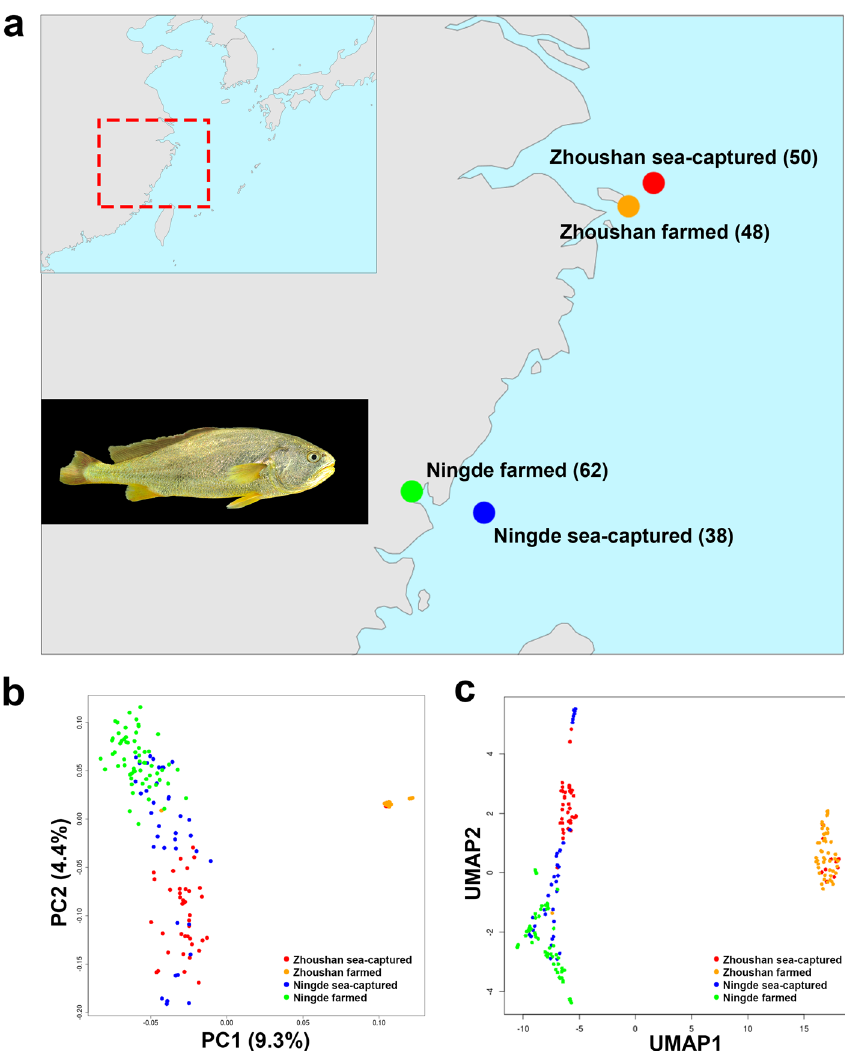
Figure 1. Population structure and relationship of large yellow croaker. ( a ) Geographic map indicating the sample origins of the large yellow croaker in this study. The gross appearance of a large yellow croaker individual is shown in the picture. The sampling area is highlighted by the red broken line. The dots of different color stand for different population. The number of individuals is given in parentheses after the population name. The geographical maps were generated by using R packages of maps v3.3.0 (https:// cran.r- proje ct. org/ web/ packa ges/ maps) and mapdata v2.3.0 (https:// cran.r- proje ct. org/ web/ packa ges/ mapda ta). ( b ) PCA plot (PC1 and PC2) showing the genetic structure of the 198 large yellow croaker individuals. The degrees of explained variance is given in parentheses. Colors reflect the geographic regions in ( a ). ( c ) UMAP of the 198 large yellow croaker individuals. Colors reflect the geographic regions in ( a